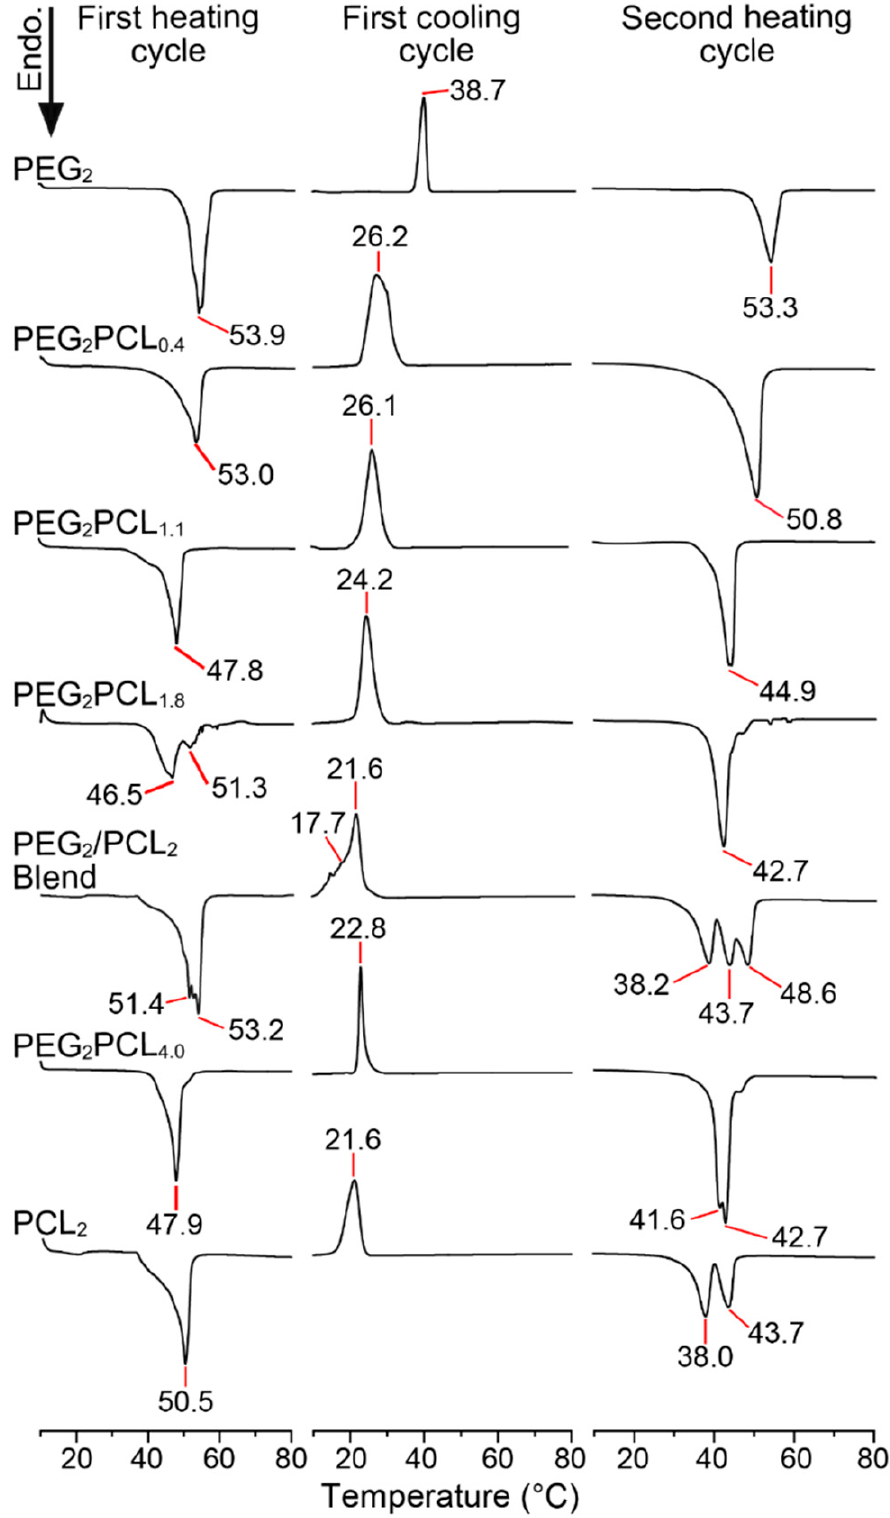
Figure 2. Representative DSC thermograms of the PEG 2 and PCL 2 homopolymers, PEG 2 PCL y copolymer series, and PEG 2 /PCL 2 (1:1 w / w ) blend, showing the first heating, first cooling, and second heating profiles (ramp rate 10 °C/min).